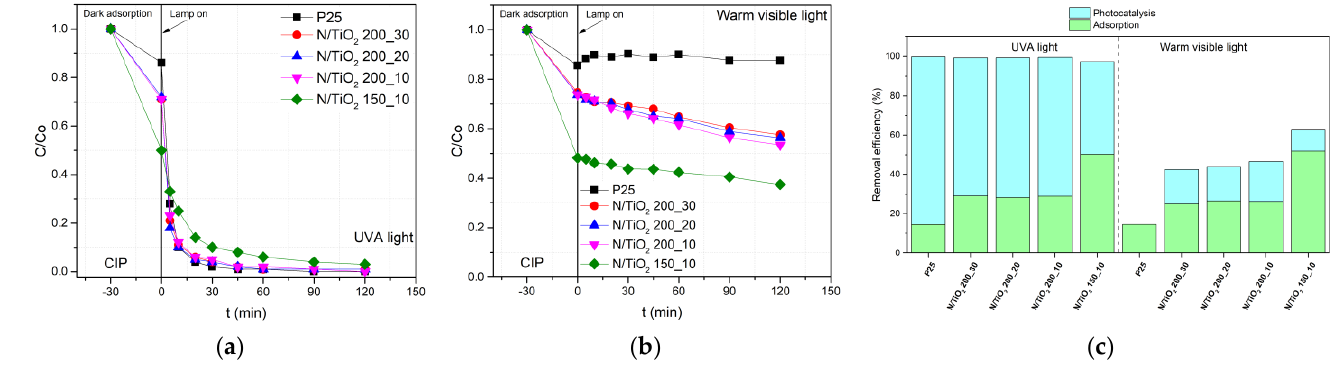
Figure 2. Photocatalytic degradation of ciprofloxacin (CIP) by Degussa P25 TiO 2 and N/TiO 2 mate- rials under the ( a ) ultraviolet A (UVA) light (lamp I) and ( b ) warm visible light (lamp III). ( c ) CIP Removal efficiencies by Degussa P25 TiO 2 and N/TiO 2 materials under the UVA and warm visible lights.